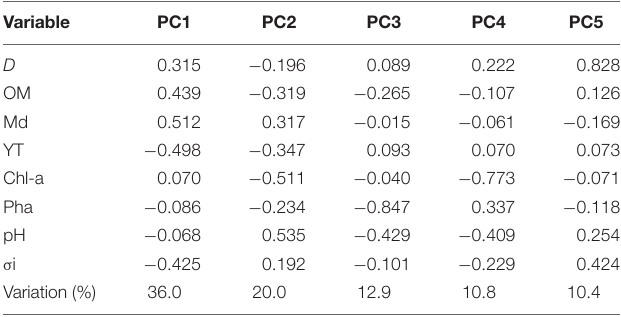
TABLE 2 | Principal component analysis of environmental variables near the Yap Trench of the Western Pacific. Variable